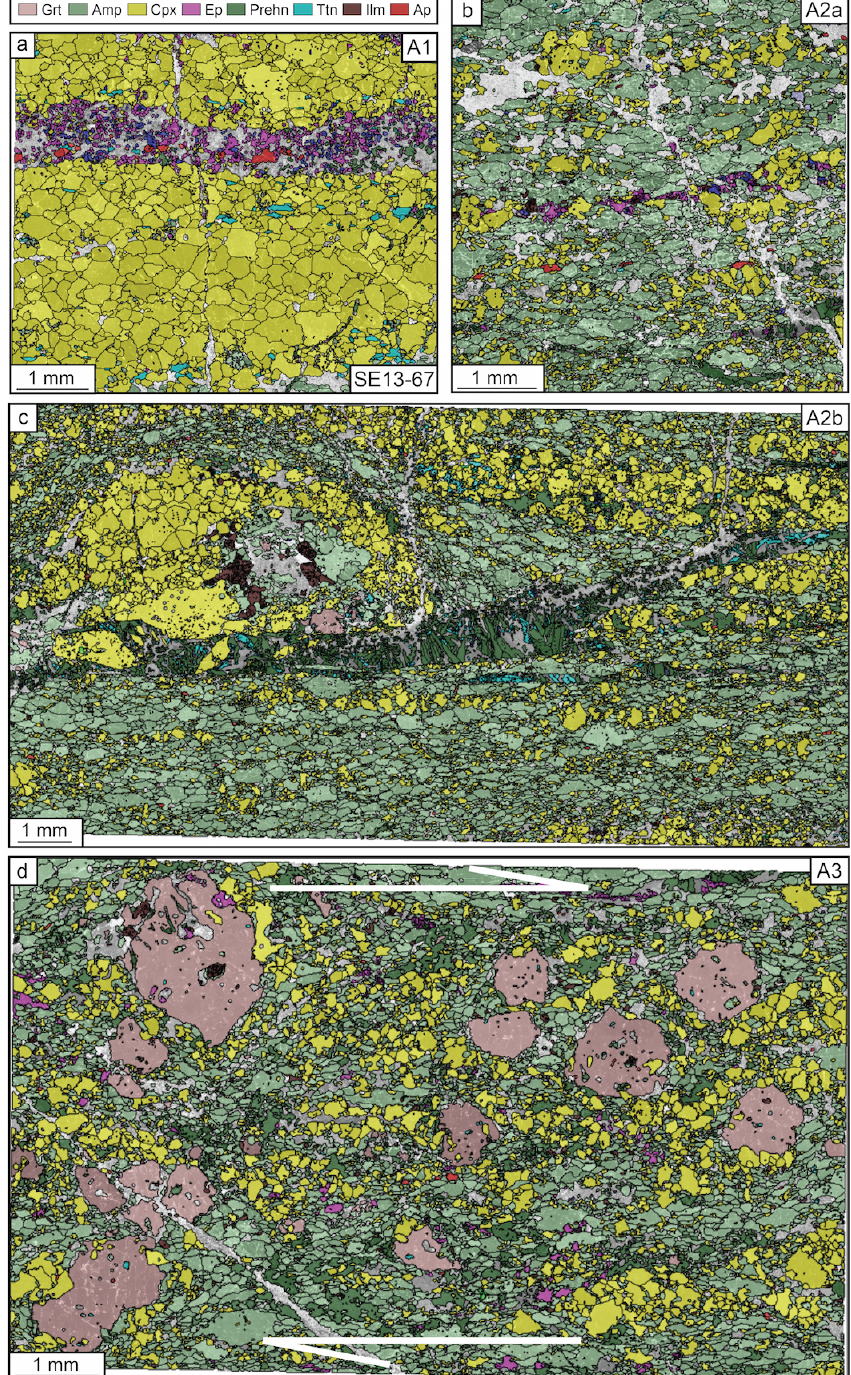
Figure 3. EBSD phase maps from a Grt–Cpx-bearing amphibolite sampled at ∼ 2 . 5m from the contact with peridotite (sample SE13-67) and showing the best-preserved microstructures. (a) Area 1 (A1) composed essentially of clinopyroxene with a late vein of epidote; (b) and (c) Area 2 (A2) composed of amphibole and clinopyroxene. (c) A late prehnite vein crosscuts the sample; (d) Area 3 (A3) composed of garnet, amphibole and